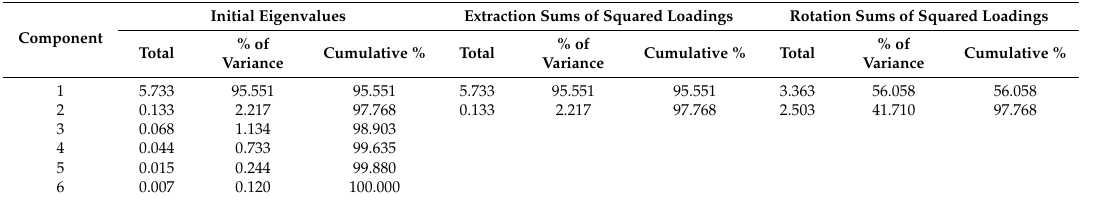
Figure 4. Principal component analysis (PCA) of the different forest types and the soil nutrients. PL = pure Larix gmelinii (Rupr.) Kuzen forest, PB = pure Betula platyphylla Suk. Forest, MLB = Larix gmelinii (Rupr.) Kuzen and Betula platyphylla Suk. mixed forest, PQ = pure Quercus mongolica Fisch . ex Ledeb. forest, PP = pure Pinus sylvestris L. var. mongolica Litv. Forest. SOC = soil organic carbon, TN = total nitrogen, TP = total phosphorus, TK = total potassium, AP = available phosphorus, and AK = available potassium. Table 1. Total variance